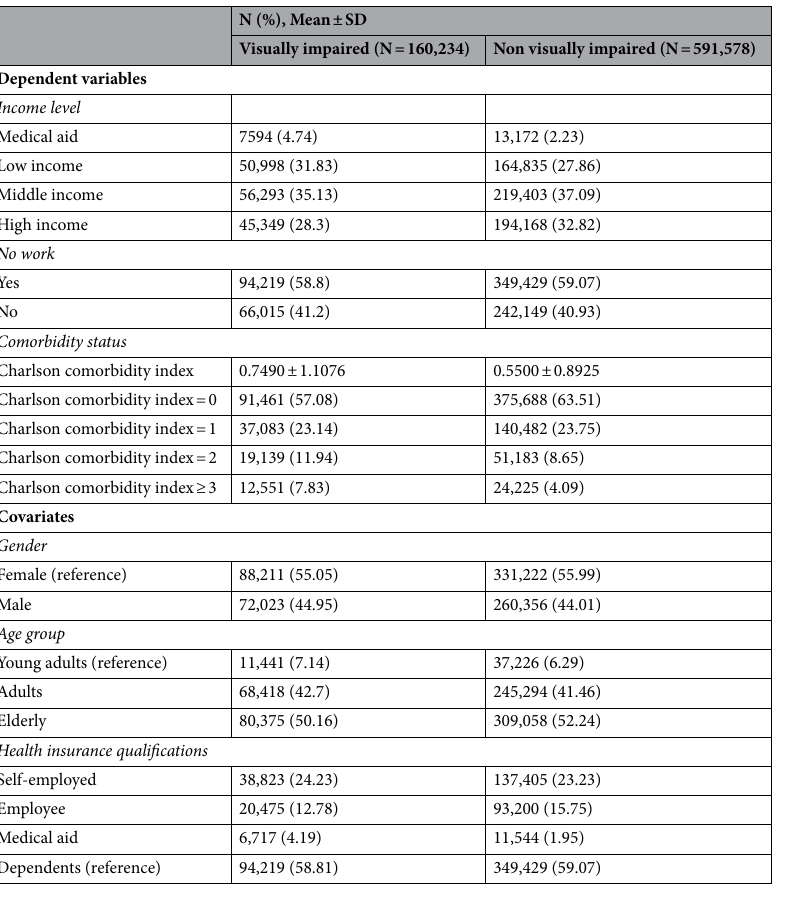
Table 1. Summary statistics (unit: